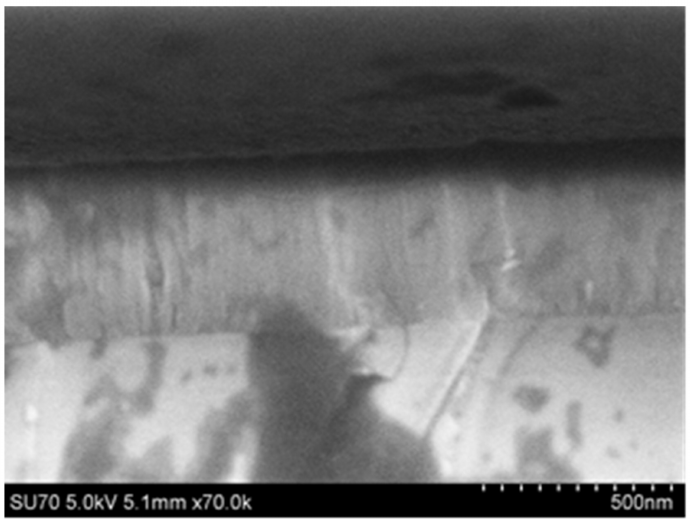
Figure 8. SEM cross-section for a GaN film grown to 500 nm thickness on c-plane sapphire.